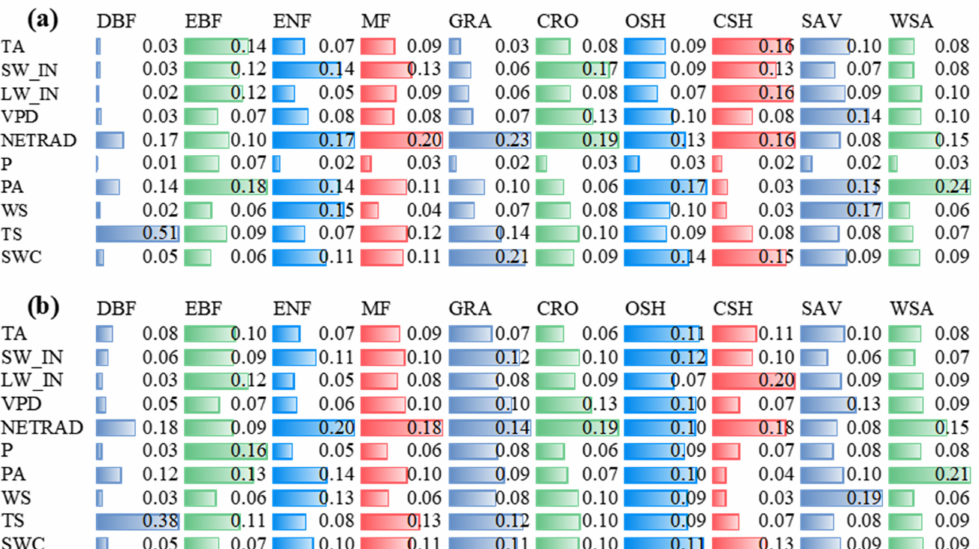
Figure 3. Impurity-based importance of variables in RF ( a ) and XGBoost ( b ) models to NEE by biomes (NEE: Net ecosystem exchange; TA: Air temperature; SW_IN: Shortwave radiation, incoming; LW_IN: Longwave radiation, incoming; VPD: Vapor pressure deficit; PA: Atmospheric pressure; P: Precipitation; WS: Wind speed; NETRAD: Net radiation; TS: Soil temperature at the shallowest; SWC: Soil water content at the